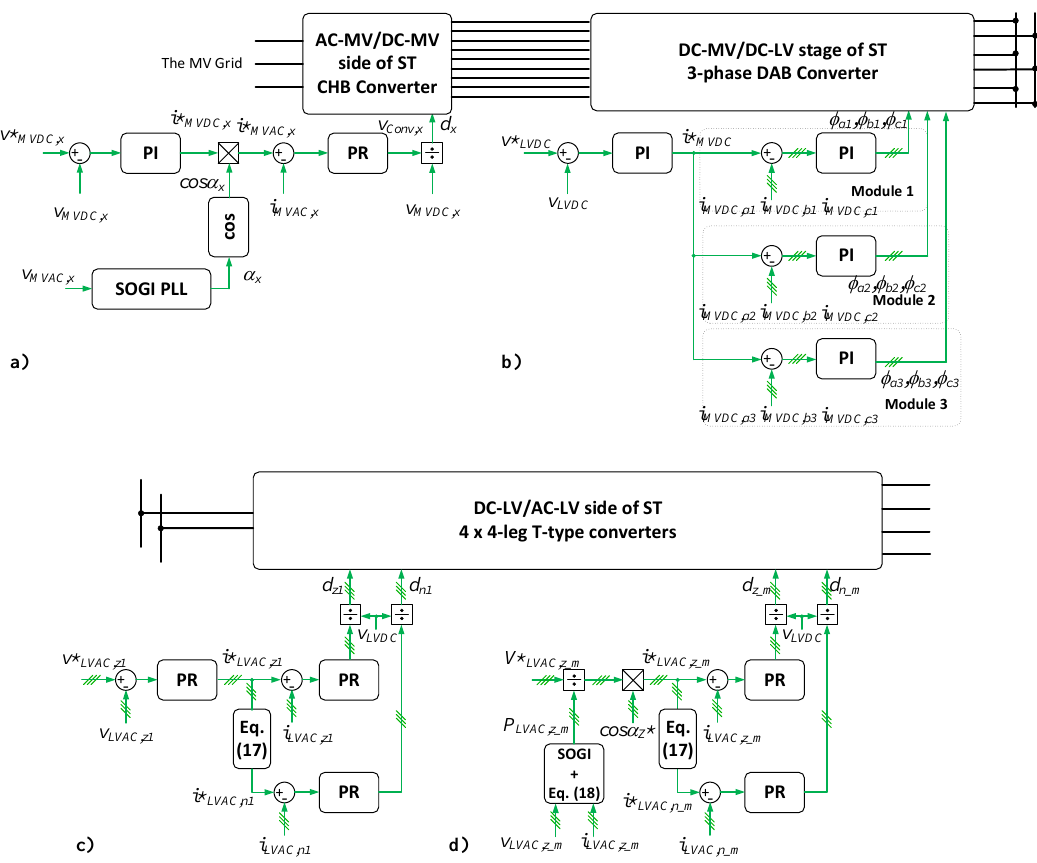
Figure 9. The block scheme of basic control algorithms used in the ST, ( a ) control loops of CHBs for the AC-MV / DC-MV side of ST, ( b ) control loops for MAB for the DC-MV / DC-LV stage of ST, ( c ) control loops for T-type converter as a controlled voltage source for DC-LV / AC-LV side of ST, ( d ) control loops for T-type converter as a controlled current source for the DC-LV / AC-LV side of ST. The simulation result of the averaged and switched model of this ST power stage is shown in Figure 10. It can be noticed that the results for the same simulation parameters are similar in steady state as well as for the dynamic change of the requested power. The most important advantage of the average model over the full switching model is the simulation time. It has been observed that the simulation time has been reduced 14 times, from 100.8 s to 6.89 s.